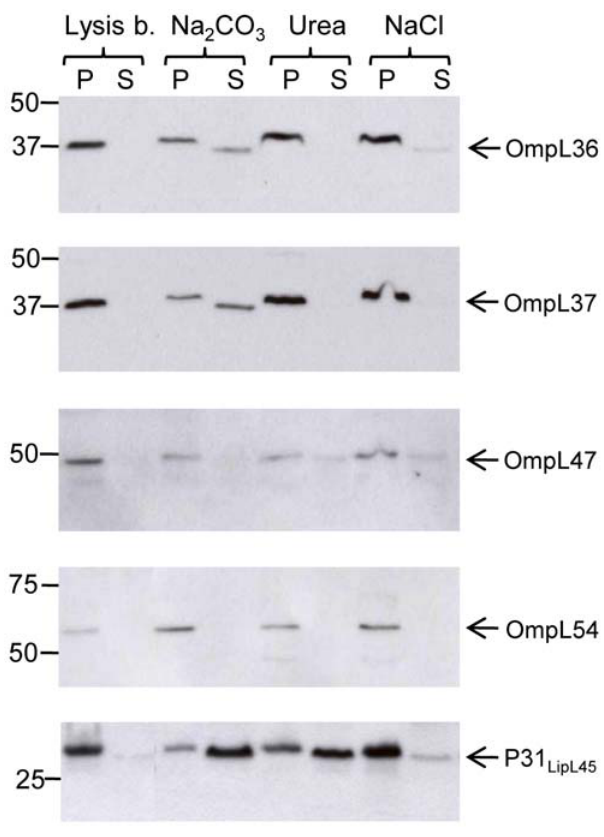
Figure 5. Membrane affinity analysis of OmpL36, OmpL37, OmpL47 and OmpL54. Membrane fraction of L. interrogans was treated with lysis buffer as a control or 0.1 M Na 2 CO 3 (pH 11), 1.6 M urea, or 0.6 M NaCl for 15 min at 4 u C. Samples were pelleted by centrifugation to separate the pellets (P) and supernatants (S), followed by gel electrophoresis (Bis-Tris 4–12% NuPage gel, Novex), and immunoblotting with specific antisera. The identities of individual proteins are indicated on the right, and the positions of molecular mass standard (in kilodaltons) are indicated on the left.